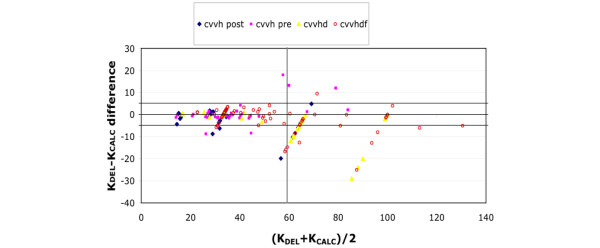
Bland–Altman analysis. The same data as above are used; here it is possible to distinguish between different modalities. Parallel lines indicate standard deviation. CVVH, continuous veno-venous hemofiltration; CVVHD, continuous veno-venous hemodialysis; CVVHDF, continuous veno-venous hemodiafiltration; KCALC, calculator-estimated urea clearance; KDEL, delivered clearance evaluated from urea concentrations on simultaneous blood and effluent samples.